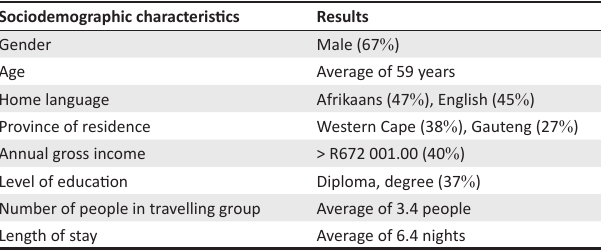
TABLE 1: Park respondents’ profile.